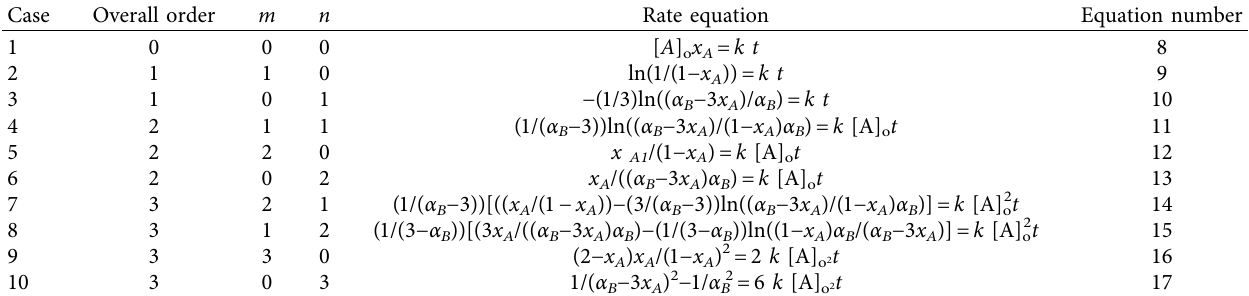
Table 1: Integrated form of rate equation (equation